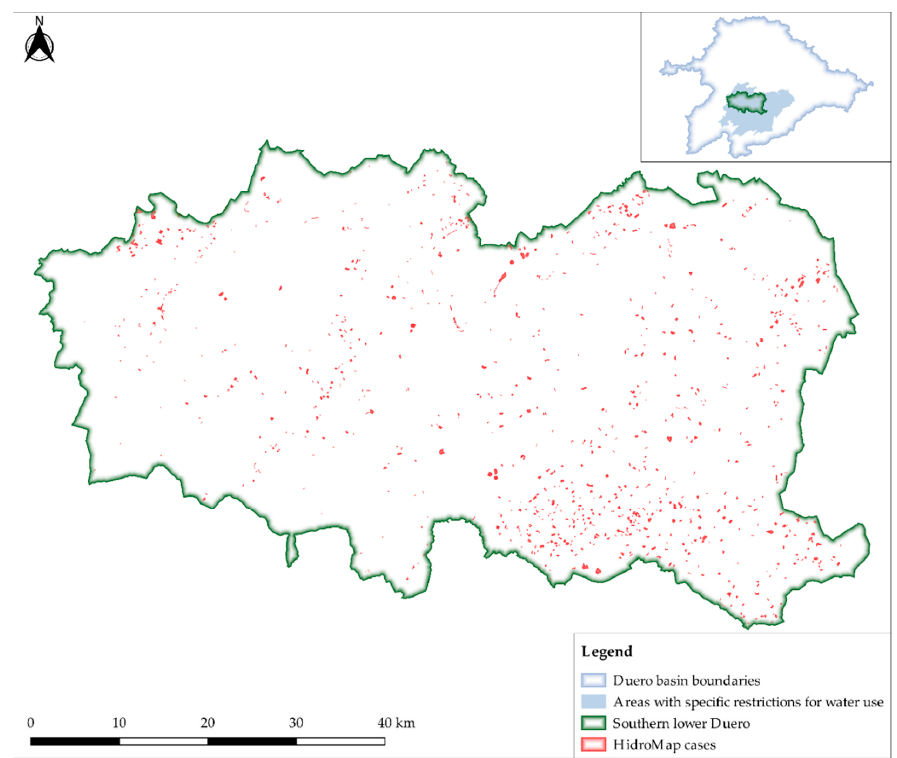
Figure 7. HidroMap cases in the Southern-lower Duero agrarian area in 2017. Plots detected with irrigation activity for an NDVI TOA threshold of 0.70, a minimum area of 0.5 ha and filtering forest